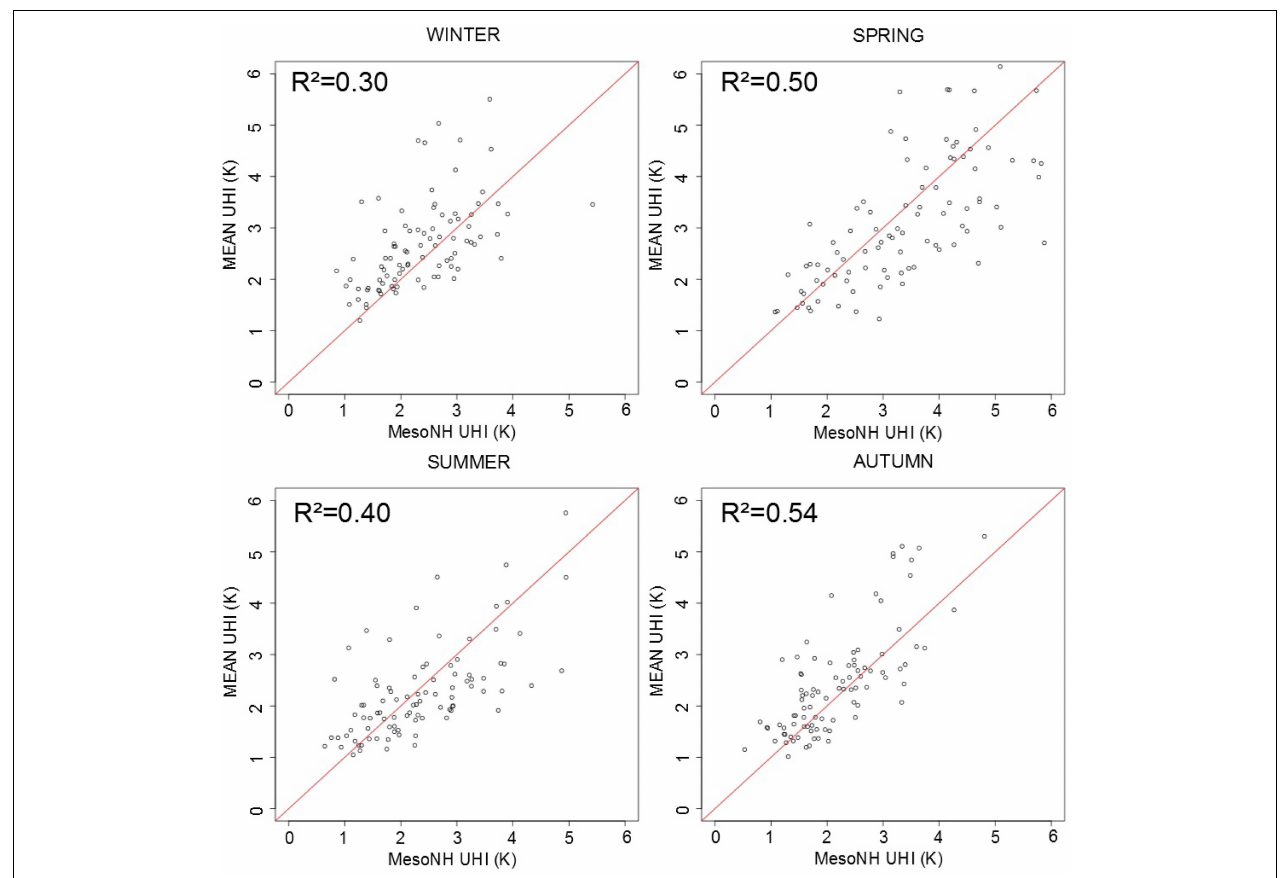
FIGURE 7 | Comparison by season of the UHI at 2m at 3:00 a.m. UTC in Paris computed by the SUWG forced with an average of data files from four different airports around Paris and a full atmospheric model MesoNH simulation.